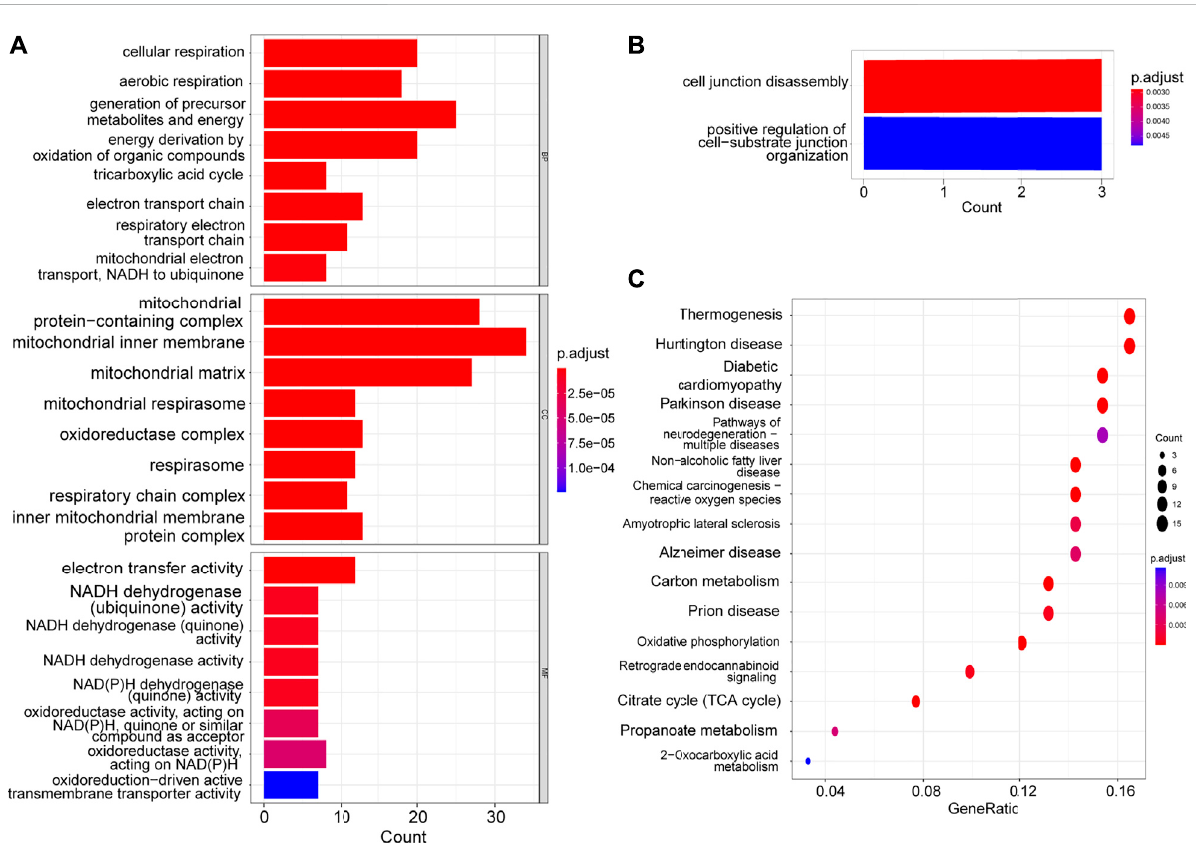
FIGURE 2 GOandKEGGenrichmentofhubgenes. (A) TheGOanalysisofthenegatively-regulatinggenes. (B) TheGOanalysisofthepositively-regulating genes. (C) The KEGG analysis of the negatively-regulating